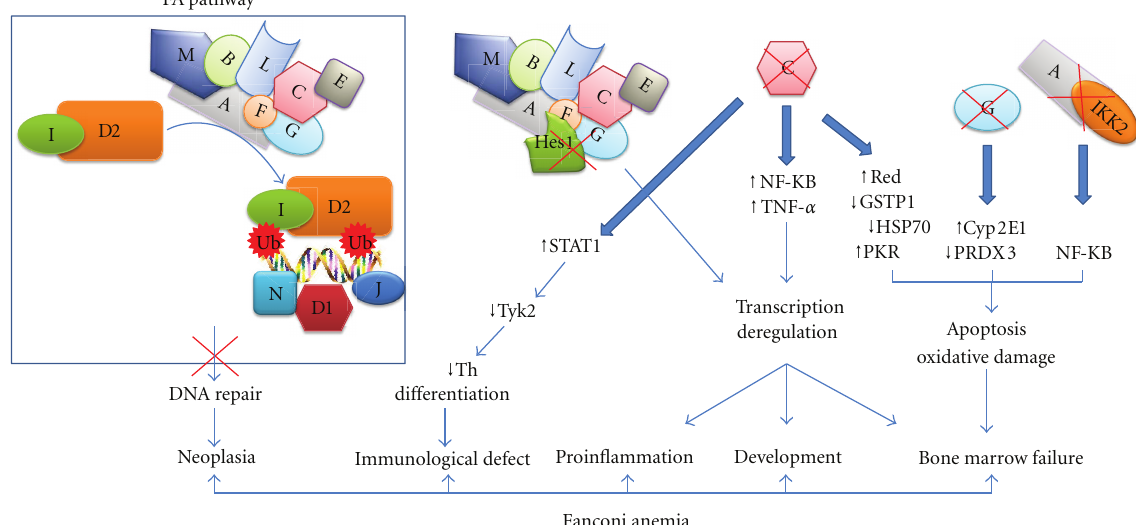
Figure 1: Putative roles of FA proteins through their interacting partners. The involvement of FA proteins with their protein partners in the di ff erent molecular mechanisms that lead to regulation of transcription, cell cycle regulation, ROS detoxification, DNA repair, and cell survival. Loss of protein interactions between FA proteins and their partners through disease causing mutations in a FA gene could lead to a defective molecular function resulting in an array of phenotypes including BMF and congenital